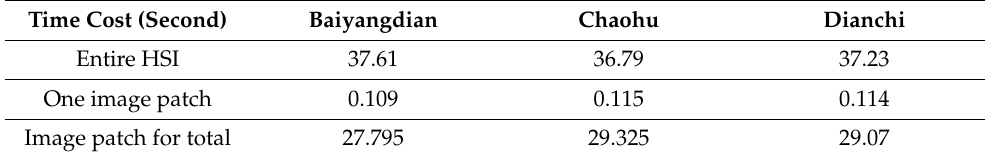
HPF 199.89 3.0215 39.2541